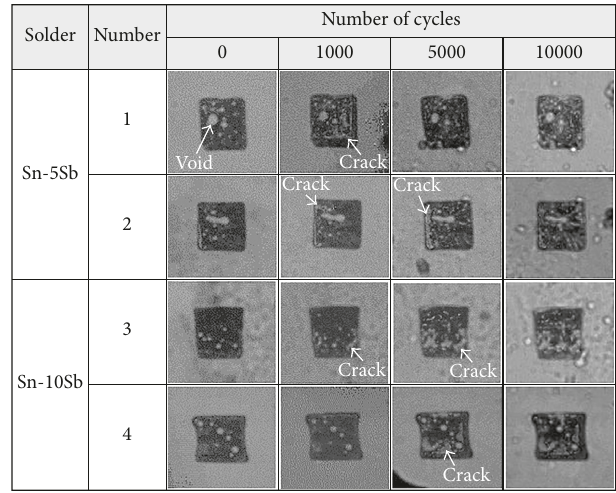
Figure 6: Scanning acoustic tomography images of solder joints after the power cycling test.